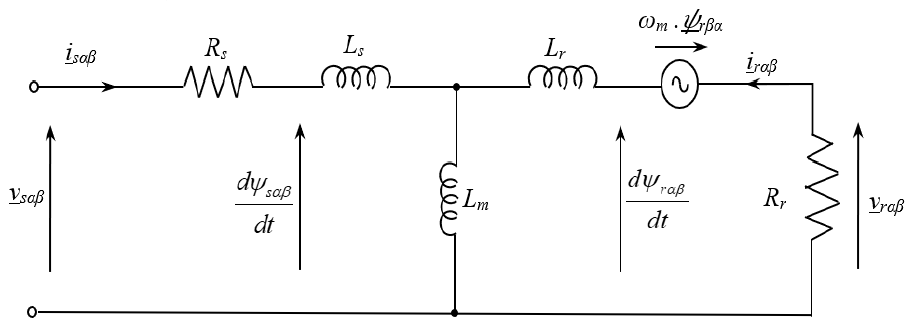
Figure 1. Model of IM in the α , β frame.